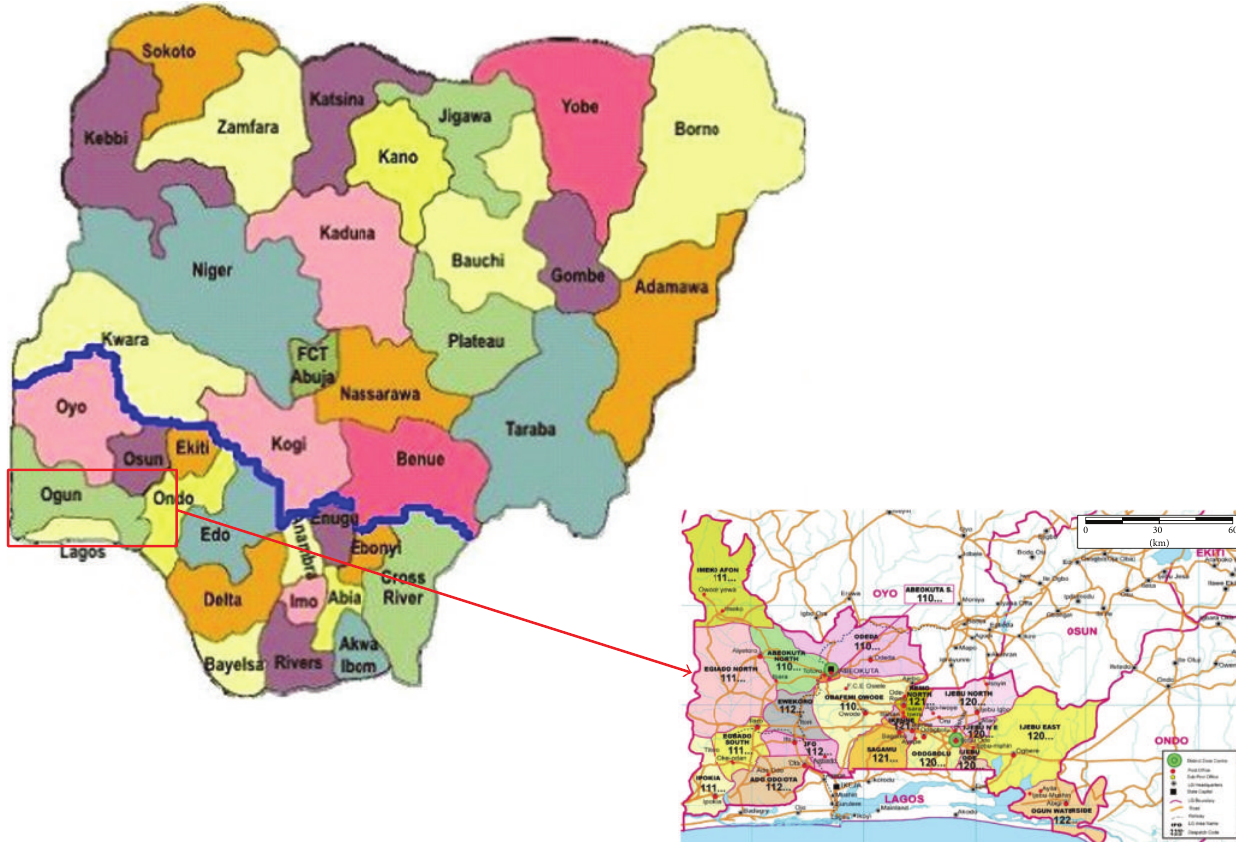
Figure 1: Location of study area in the enclave of Nigeria.